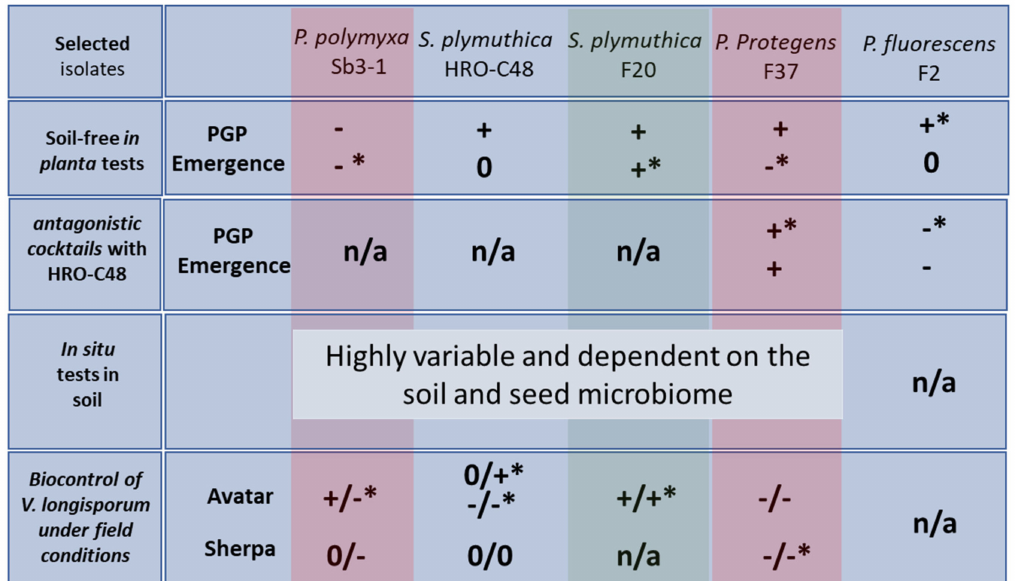
Figure 1. Summary of the selection strategy and results in the development of a novel biocontrol agent against verticillium wilt in oilseed rape. The ” / ” sign was used when several fields / conditions were tested. Asterix (*) indicates a significant result under all conditions tested, while n / a means that no data is available. The data derives from this study as well as from the following publications